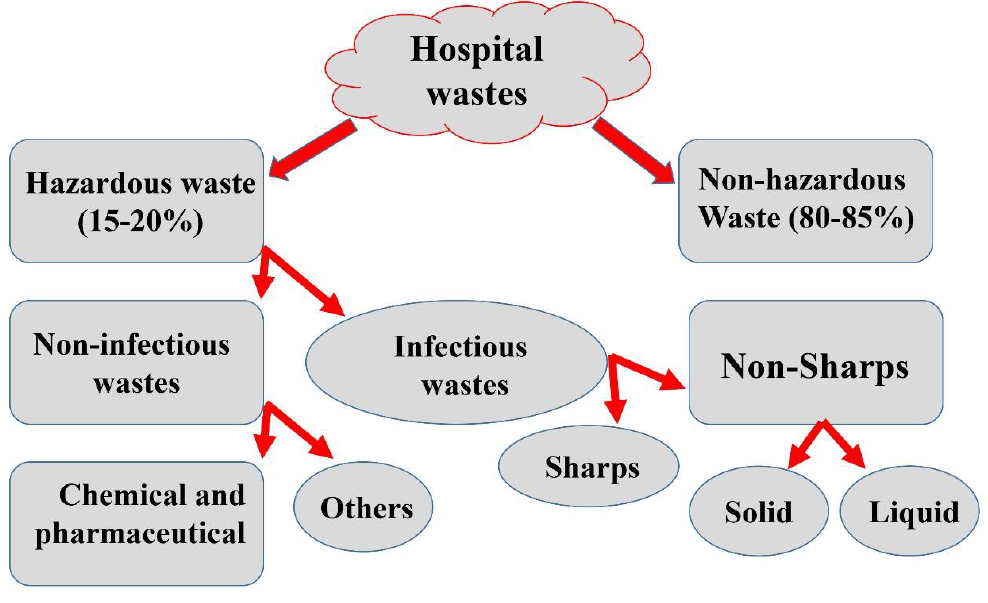
Figure 4. The schematic representation of different types of hospital waste.